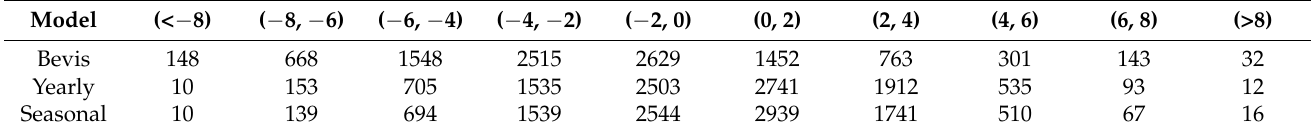
Table 8. Deviation distribution of Bevis model, yearly and seasonal three-factor RTMs (K).